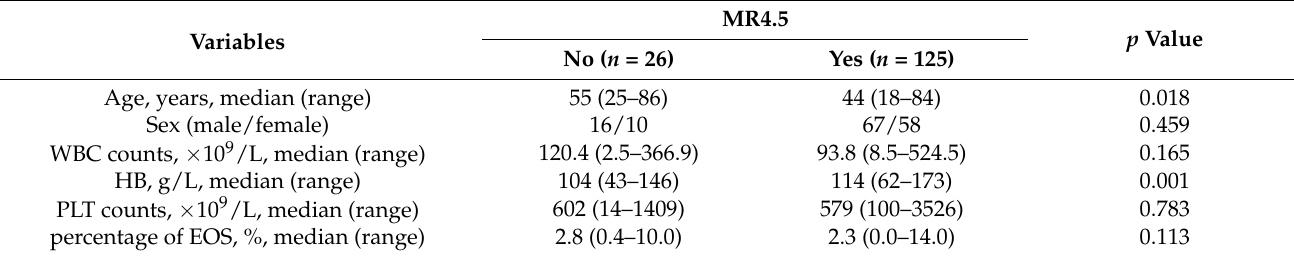
Table 4. Analysis of clinical characteristics, risk stratification and molecular response of 151 CML-CP patients.